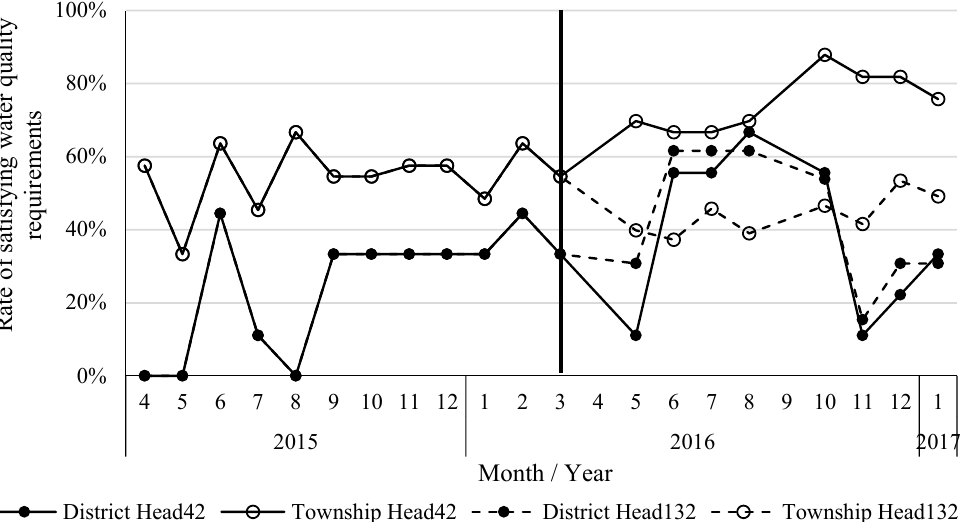
Figure 6. Rate of satisfying the Grade V requirements for the first 42 rivers and later 132 rivers (90 rivers have been included since March 2016) under the river chiefs at the district and township levels. (Source: Official website of Foshan Environmental Protection Bureau).